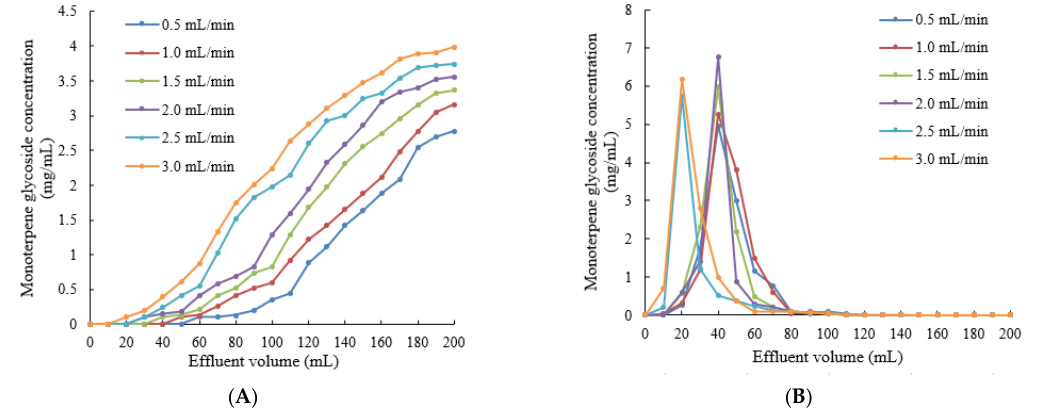
Figure 5. Effect of the sample solution flow rate on the adsorption of LSA-900C macroporous resin ( A ) and effect of the eluent flow rate on the desorption of LSA-900C macroporous resin ( B ).